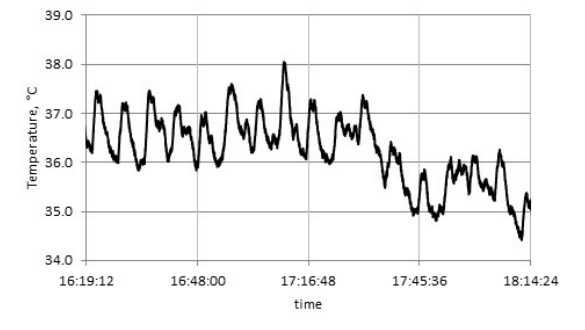
Figure 7: Air temperature in the exhaust duct.